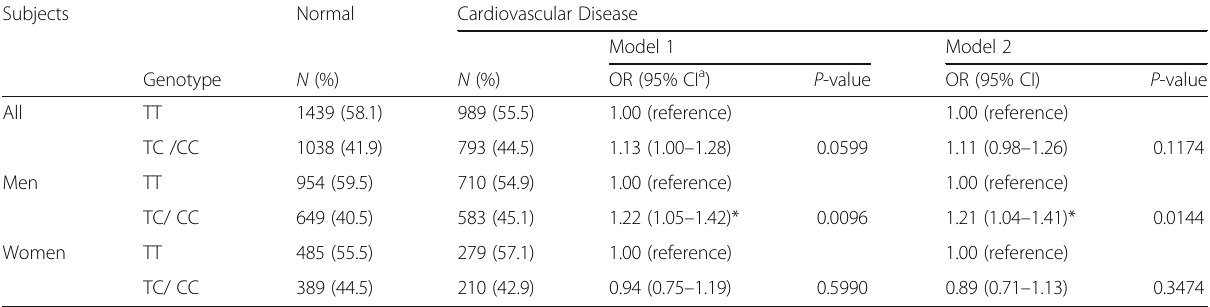
Table 4 Odds ratios (OR) of the polymorphic rs17782313 MC4R genotypes for cardiovascular disease in the population ( n = 4259) Subjects